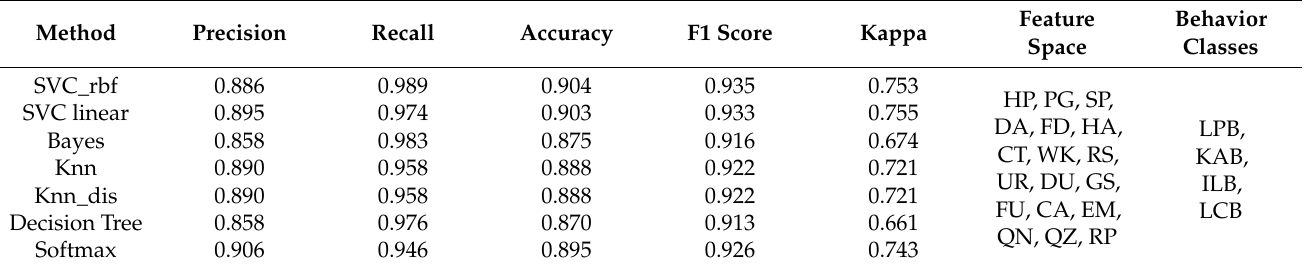
Table 3. DEM’s optimal solution and optimal feature